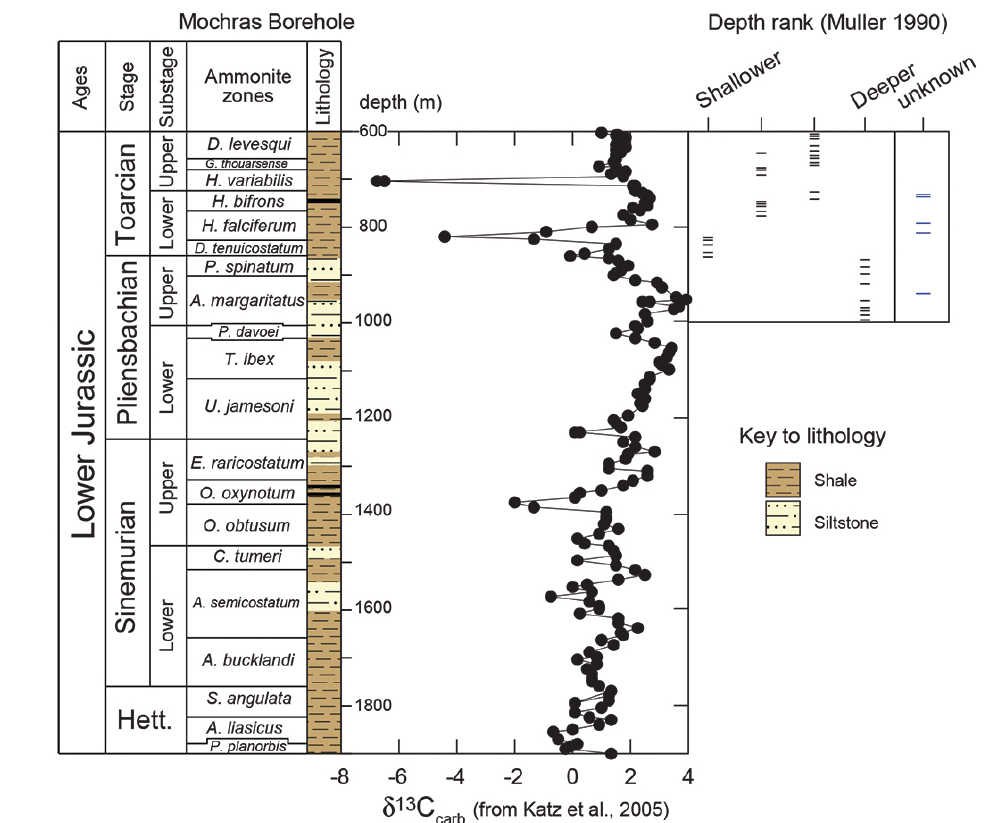
Figure 6. Carbon-isotope profile from bulk carbonate and palaeodepth changes inferred from benthic foraminifers. Modified after van de Schootbrugge et al. (2005). Hett. =